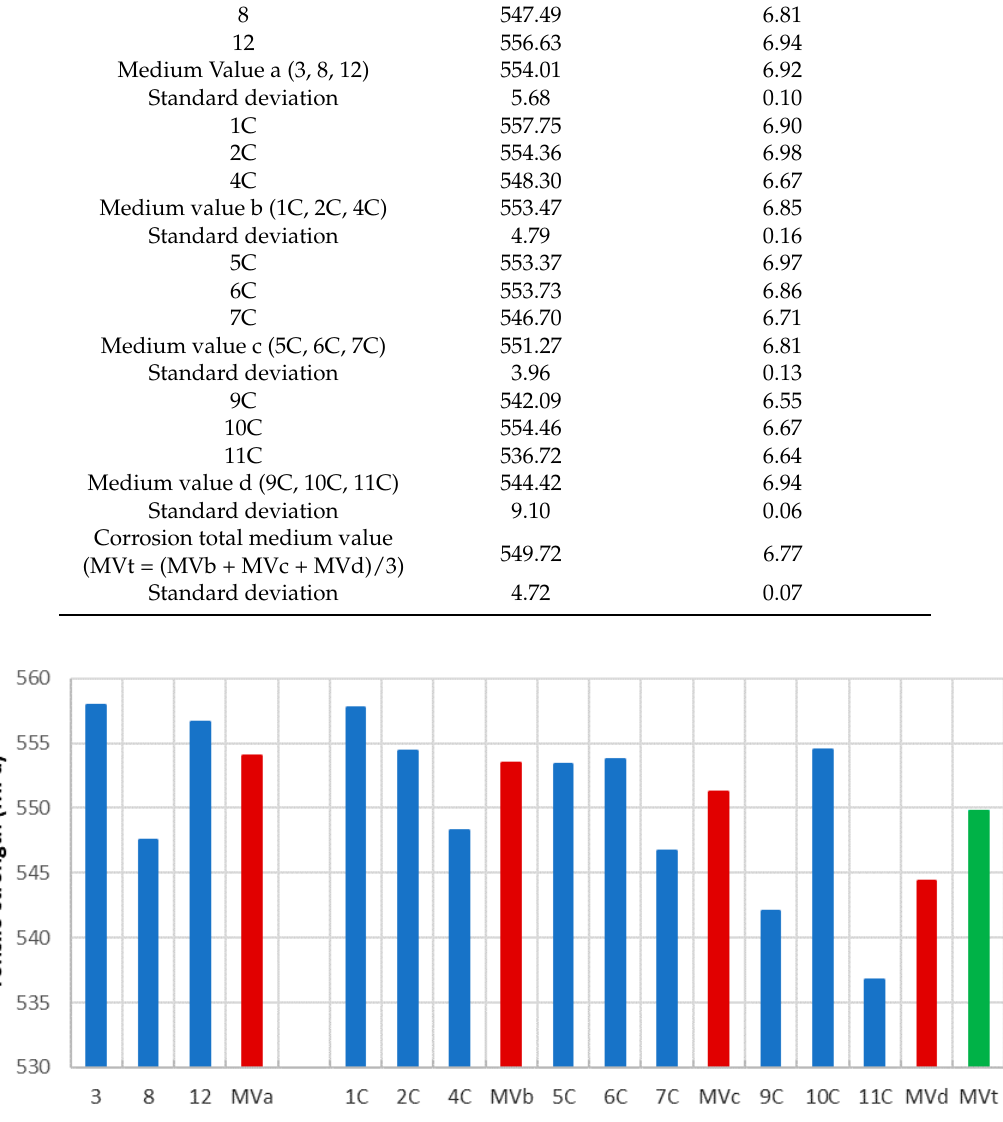
Table 5. Tensile strength and tensile strength/section relation values per specimen and medium values.